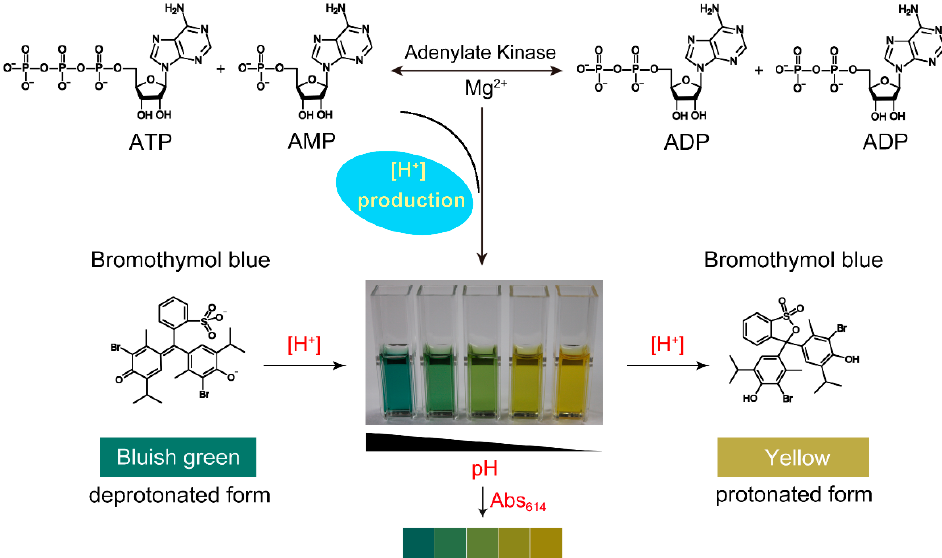
Figure 1. The principle of the spectrophotometric assay for adenylate kinase (Adk) activity.